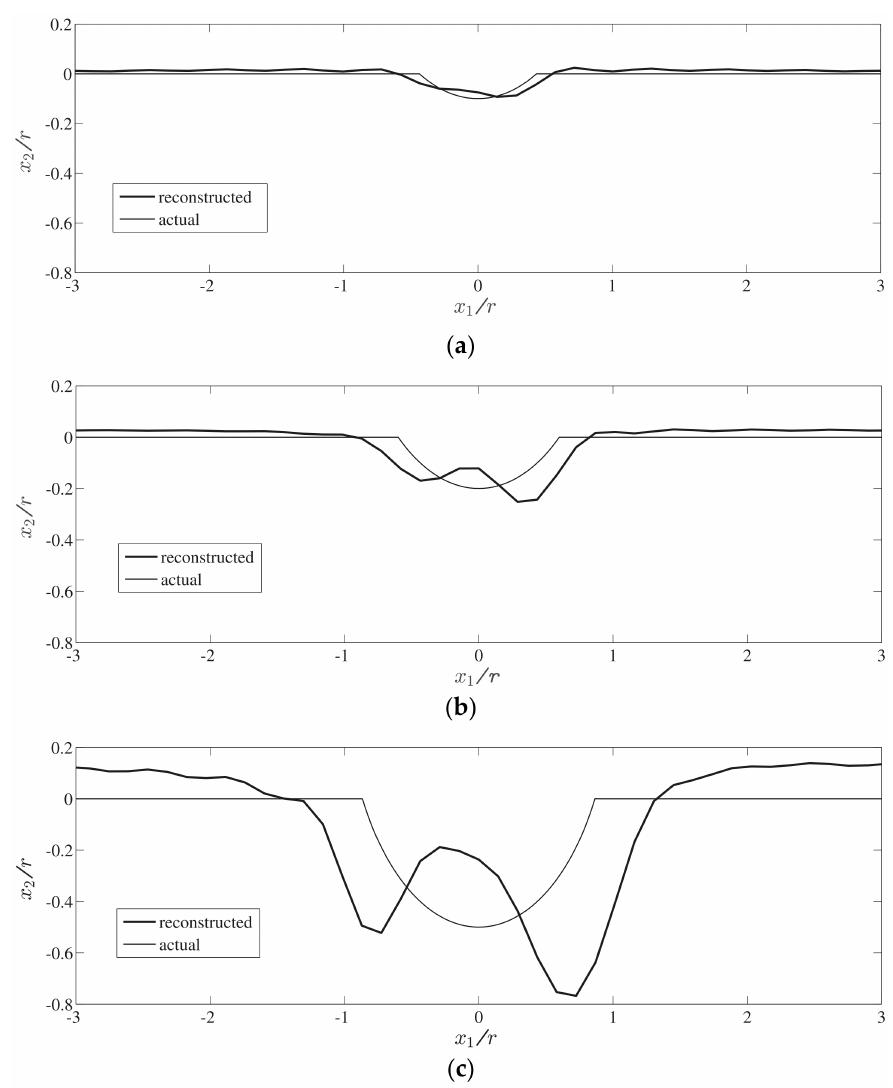
Figure 9. Inverse reconstruction results of surface canyon-shaped flaws with different depth–radius ratios ( a ) d max / r = 0.1; ( b ) d max / r = 0.2; ( c ) d max / r =